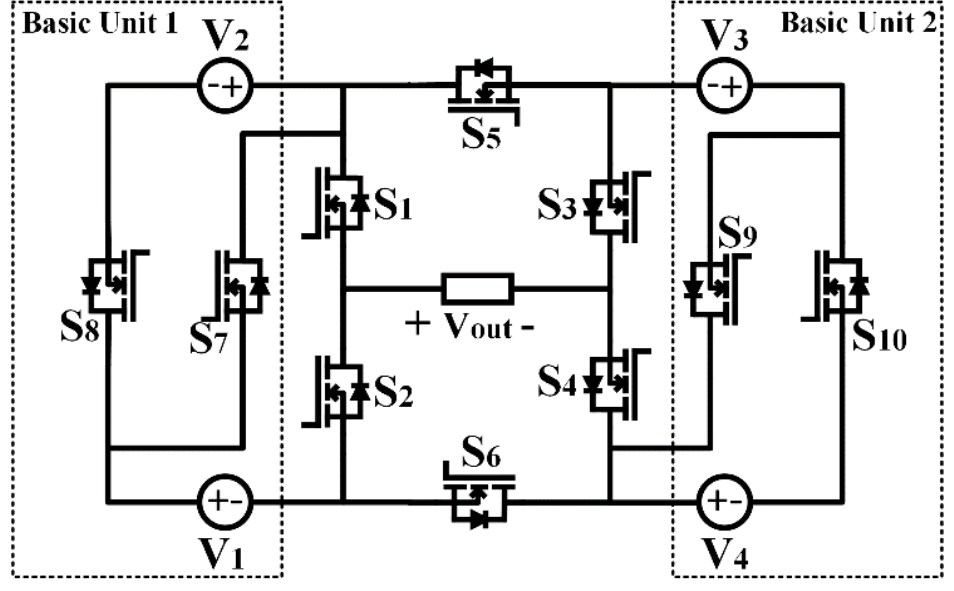
Figure 1. Selected MLI topology.